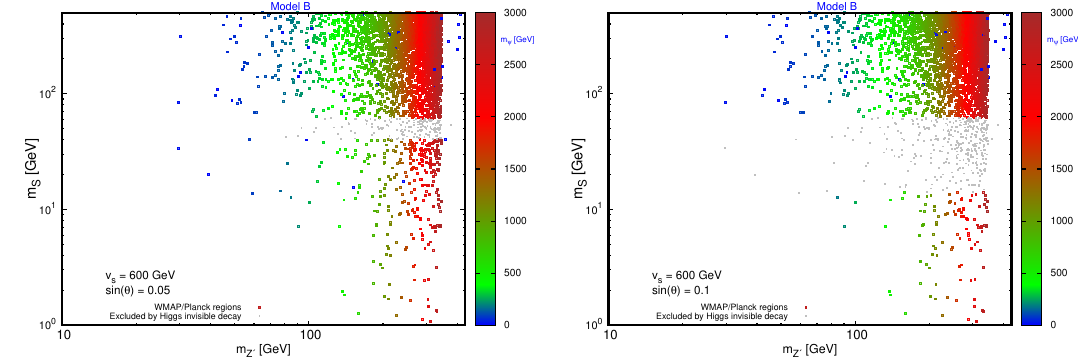
Figure 2 . The plots show the mass of the Z 0 against the mediator mass in model B for two mixing angles left) sin (cid:18) = 0 : 05 and right) sin (cid:18) = 0 : 1. The gray points are excluded by the invisible Higgs decay bound. The scan is done over the parameters with 10 (cid:0) 3 < g 0 < 1, 1 GeV < m s < 500 GeV and 10 GeV < m < 3 TeV. In the scans v s = 600